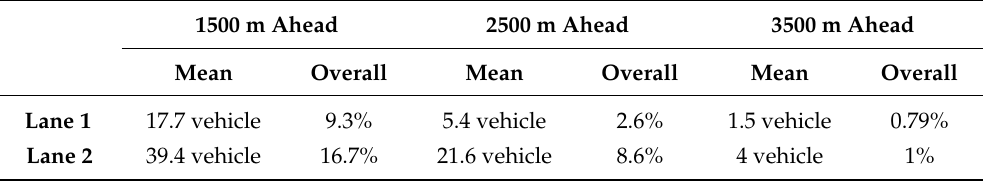
Table 5. The mean of remaining vehicles that did not execute lane-changing in Lane 1 and Lane